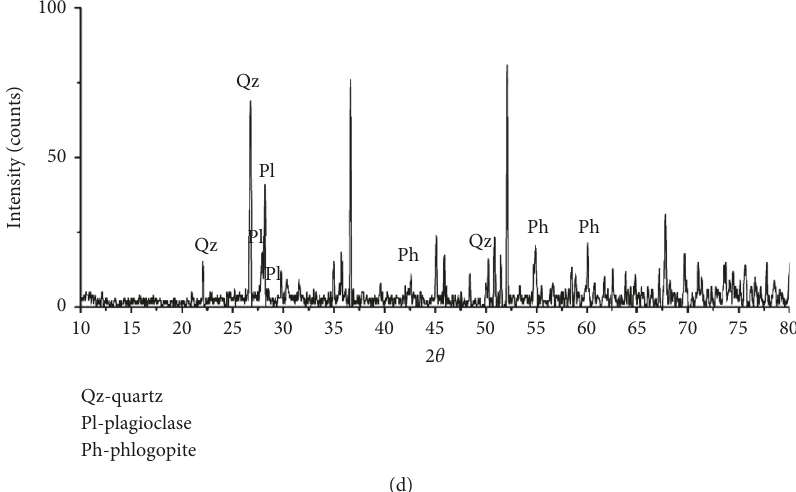
Figure 7: XRD results for tonalite specimens: (a) under natural conditions; (b) after cycling between 20 ° C and between 20 ° C and 40 ° C; (d) after cycling between 20 ° C and −